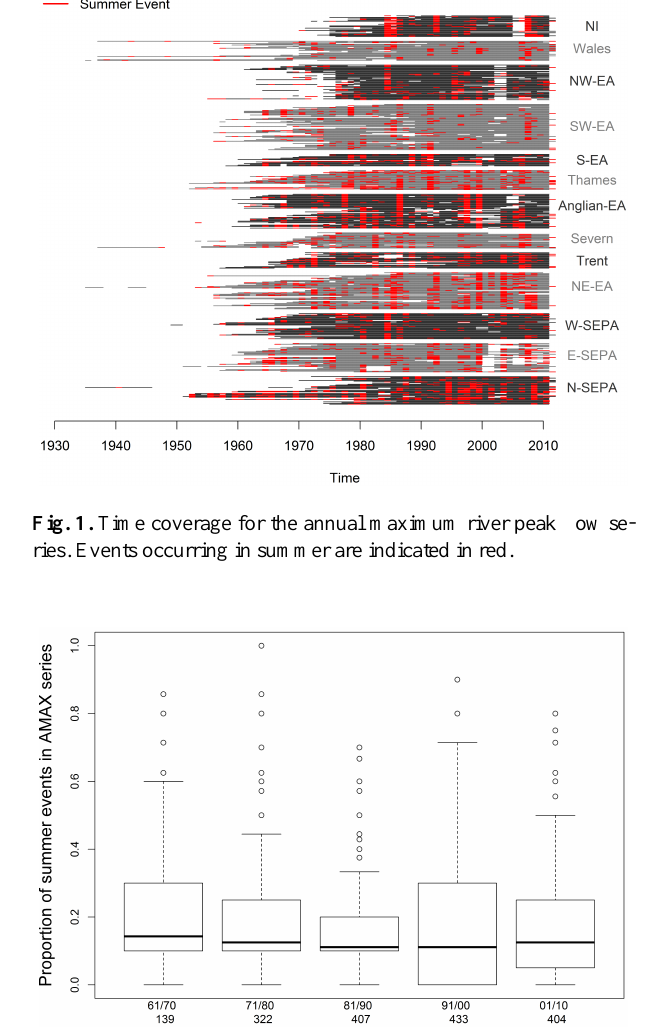
Fig. 2. Proportion of summer events in the annual maximum peak river flow series, shown separately for each decade. The number of stations with at least 7years of data used to compute the proportions is indicated below the x